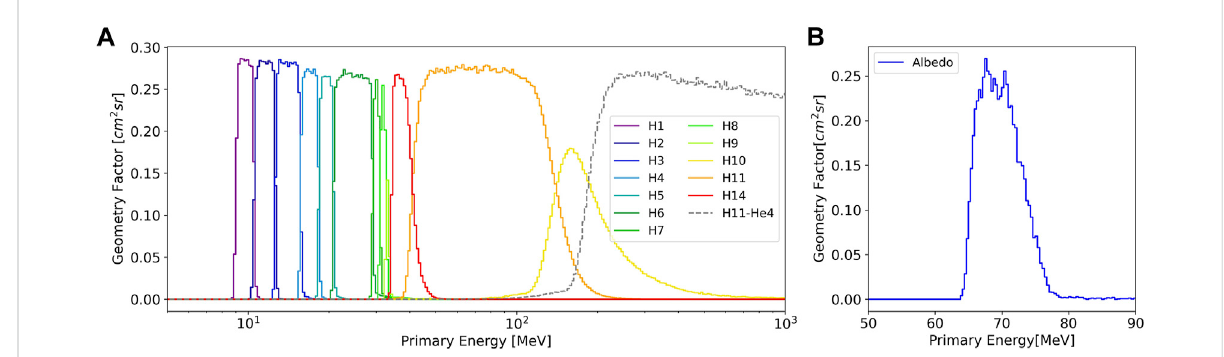
FIGURE 3 Thegeometryfactorsforbothdownwardprotonsin (A) stoppingchannels(H1-H9)andpenetratingones(H10,H11,H14),andalbedoprotonsin (B) are based on an input spectrum with power index γ =